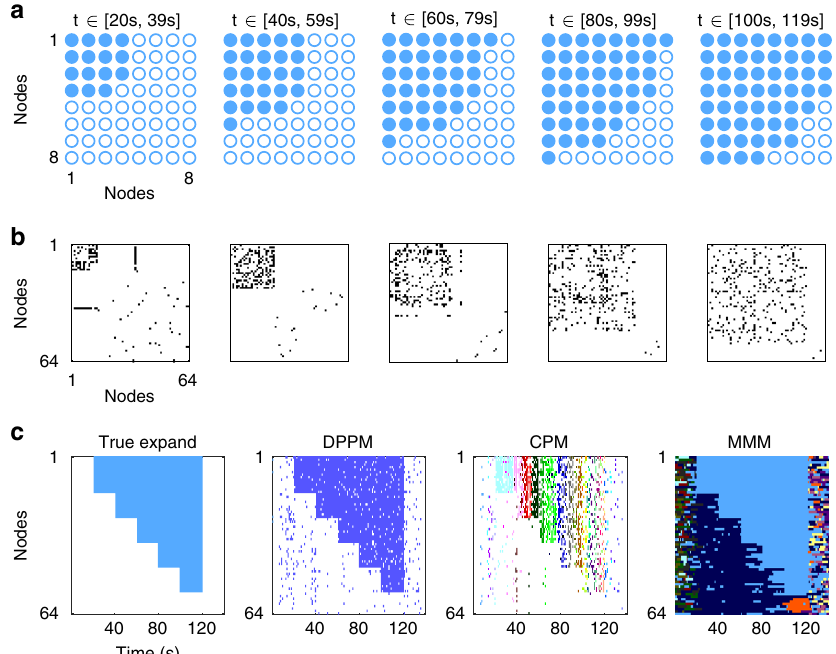
Fig. 2 In an example of dynamic community expansion, DPPM outperforms two existing methods. Illustration of community expansion in nodes ( a ) and in edges ( b ). a Two-dimensional representation of the nodes on an 8 × 8 grid at fi ve time intervals. Color (blue) indicates when a node becomes recruited to the largest community. b Adjacency matrices for the simulated network of 64 nodes at the same fi ve time intervals. Color (black) indicates an edge between a node pair. c Dynamic community detection results for each method, from left to right: true expansion, DPPM with parameters m = 4 and k = 2, CPM with parameter m = 4, and MMM with parameters γ = 0.1, ω = 0.1; see Supplementary Figs. 2 and 6a for results with different parameter choices, and see Fig. 4a, e for average results over 100 realizations of the simulation. Color indicates community membership. The largest community detected by DPPM is most consistent with the true